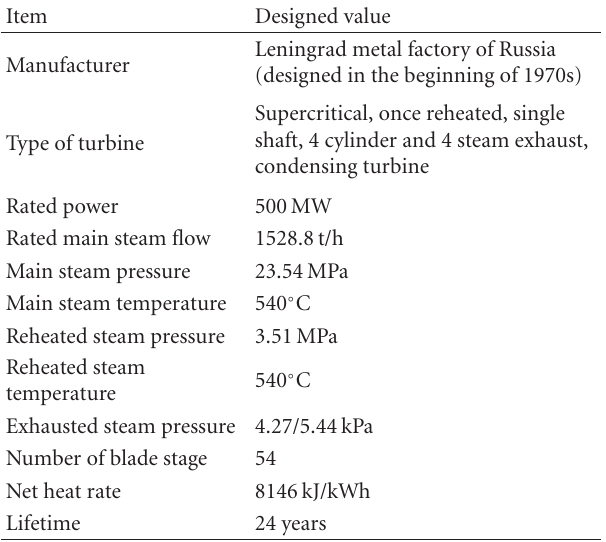
Figure 2: Profile of turbine. Table 1: The principal specifications of the steam